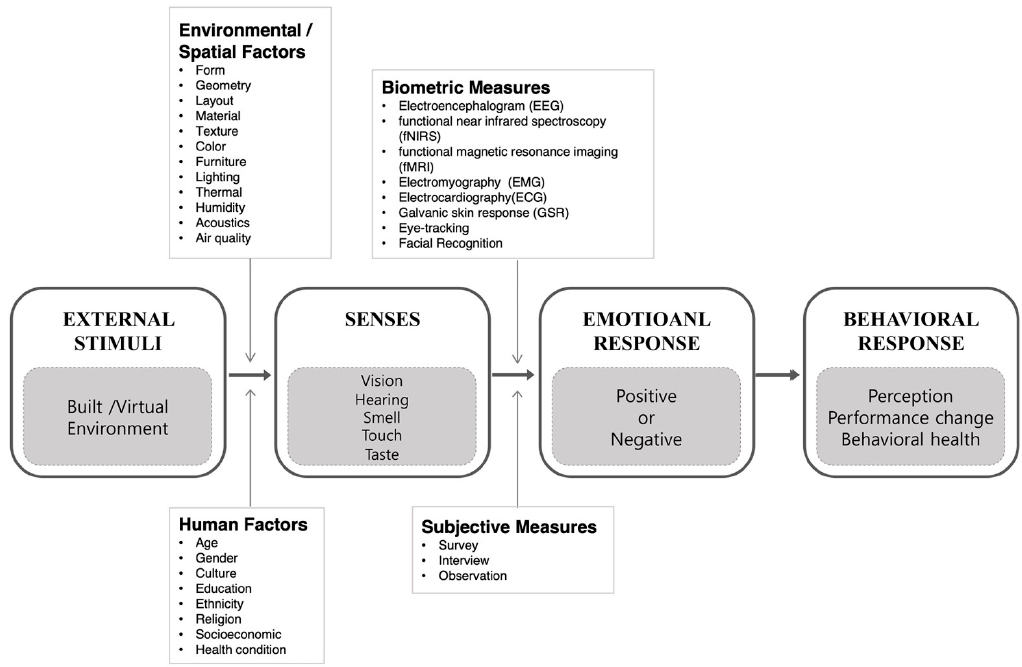
Figure 2. Conceptual framework for future implications.